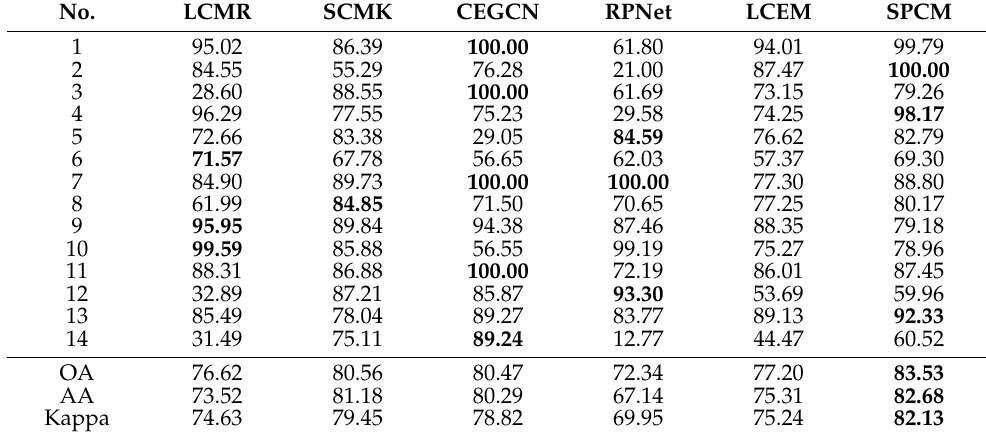
Table 3. Classification results obtained by LCMR, SCMK, CEGCN, RPNet, LCEM, and SPCM using 1% of the available labelled data for training with the Botswana data set. The best results are expressed in bold.